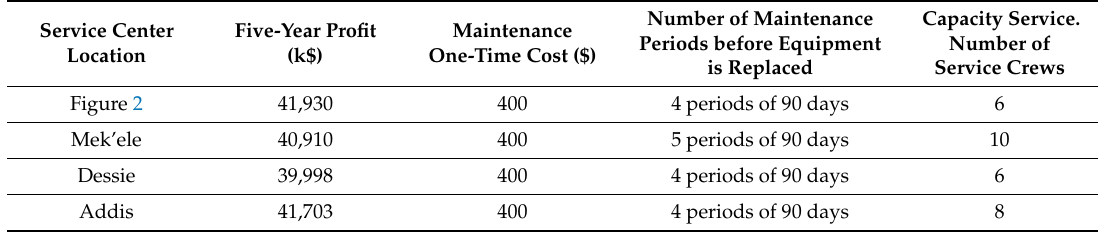
Table 4. Optimization scenarios for four di ff erent locations of the service center, all other input parameters being the same. Time window of five